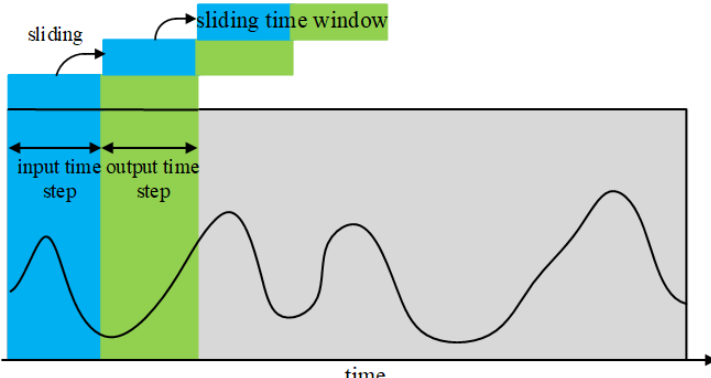
Figure 8. Sliding time